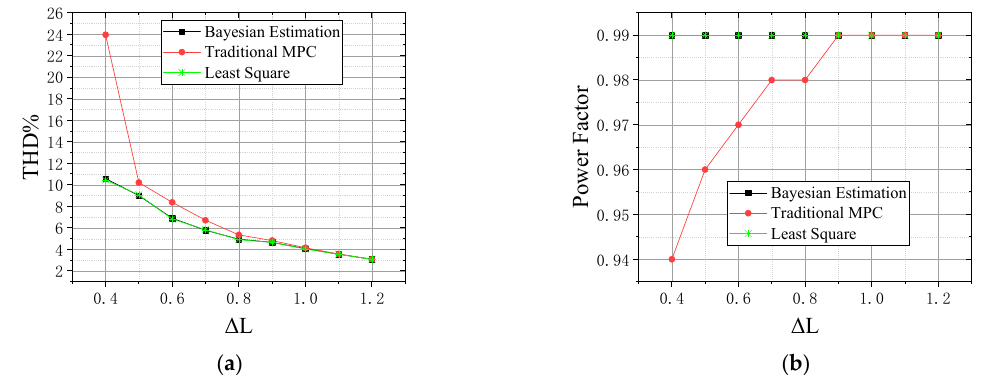
Figure 11. Current harmonic content and power factor as inductance parameter changes with different MPDPC methods. ( a ) Current harmonic content under the parameter’s variation; ( b ) Power factor under the inductance value’s variation.